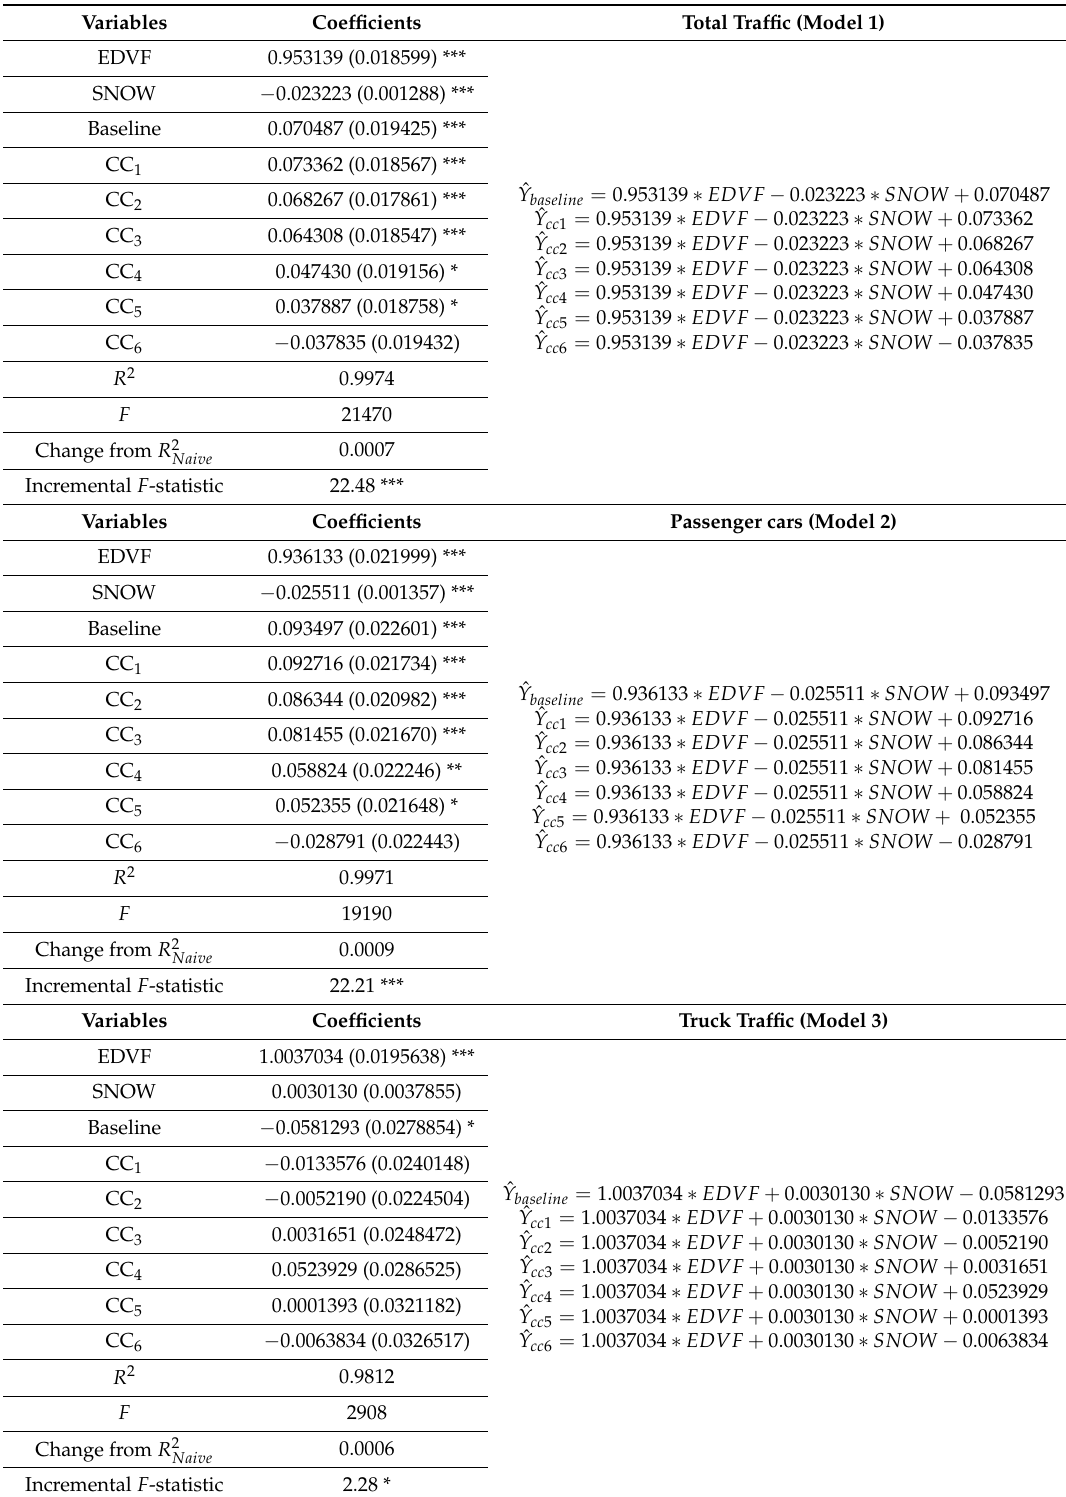
Table 2. Daily winter weather regression models with dummy variables at Leduc Hwy